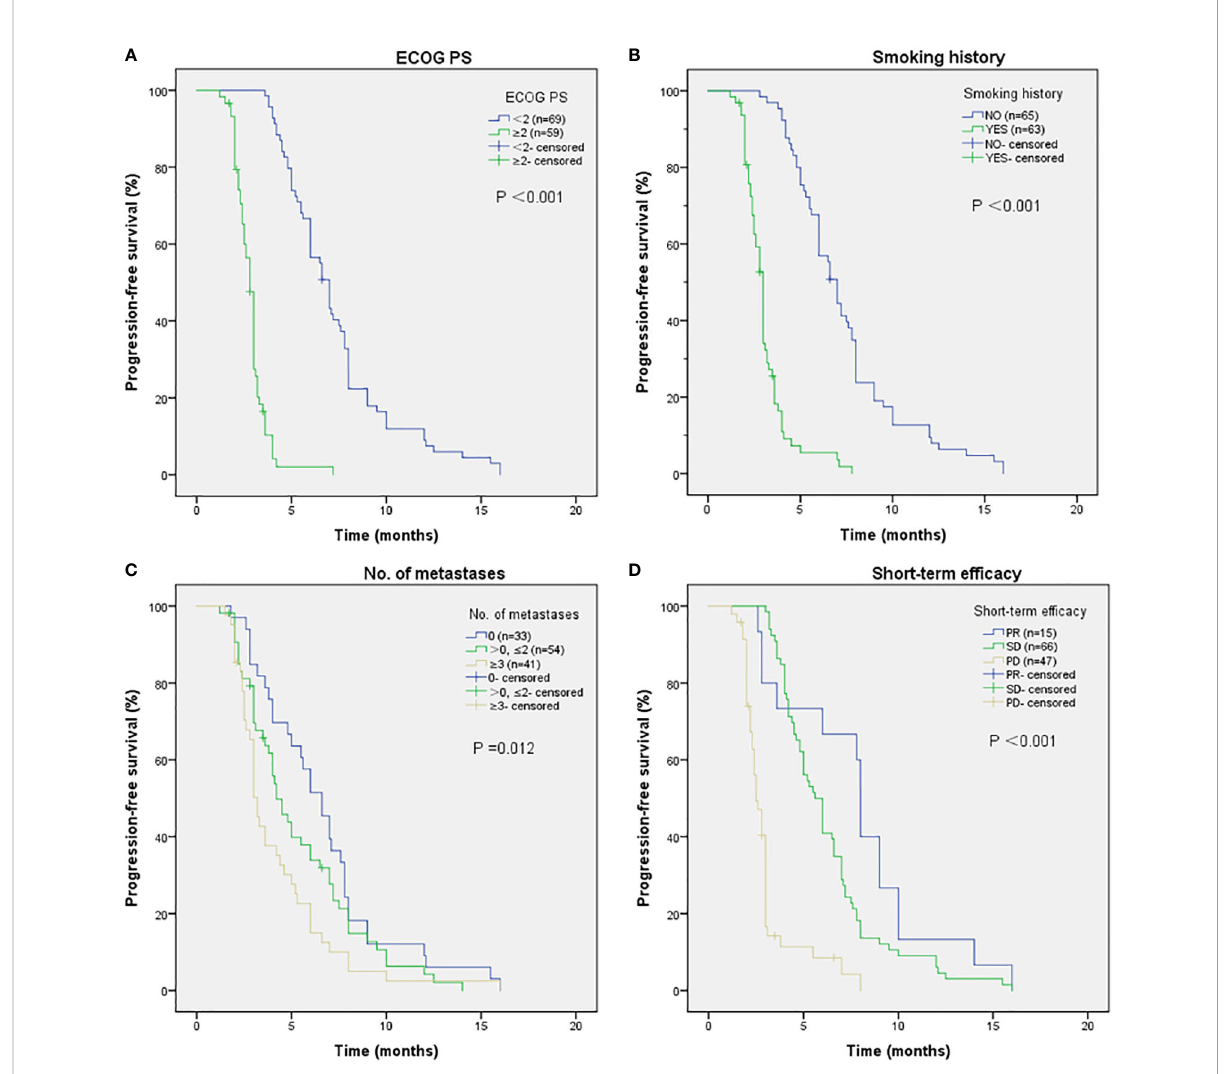
FIGURE 3 The relationship between ECOG PS and PFS (A) , with P- value <0.001. Patients with smoking history have poorer PFS (B) , with P- value <0.001. The relationship between No. of metastases and PFS (C) , with P- value of 0.012. The relationship between short-term ef fi cacy and PFS (D) . No people reached CR, people who reached PR had better PFS results than people who suffered SD and PD, with P- value